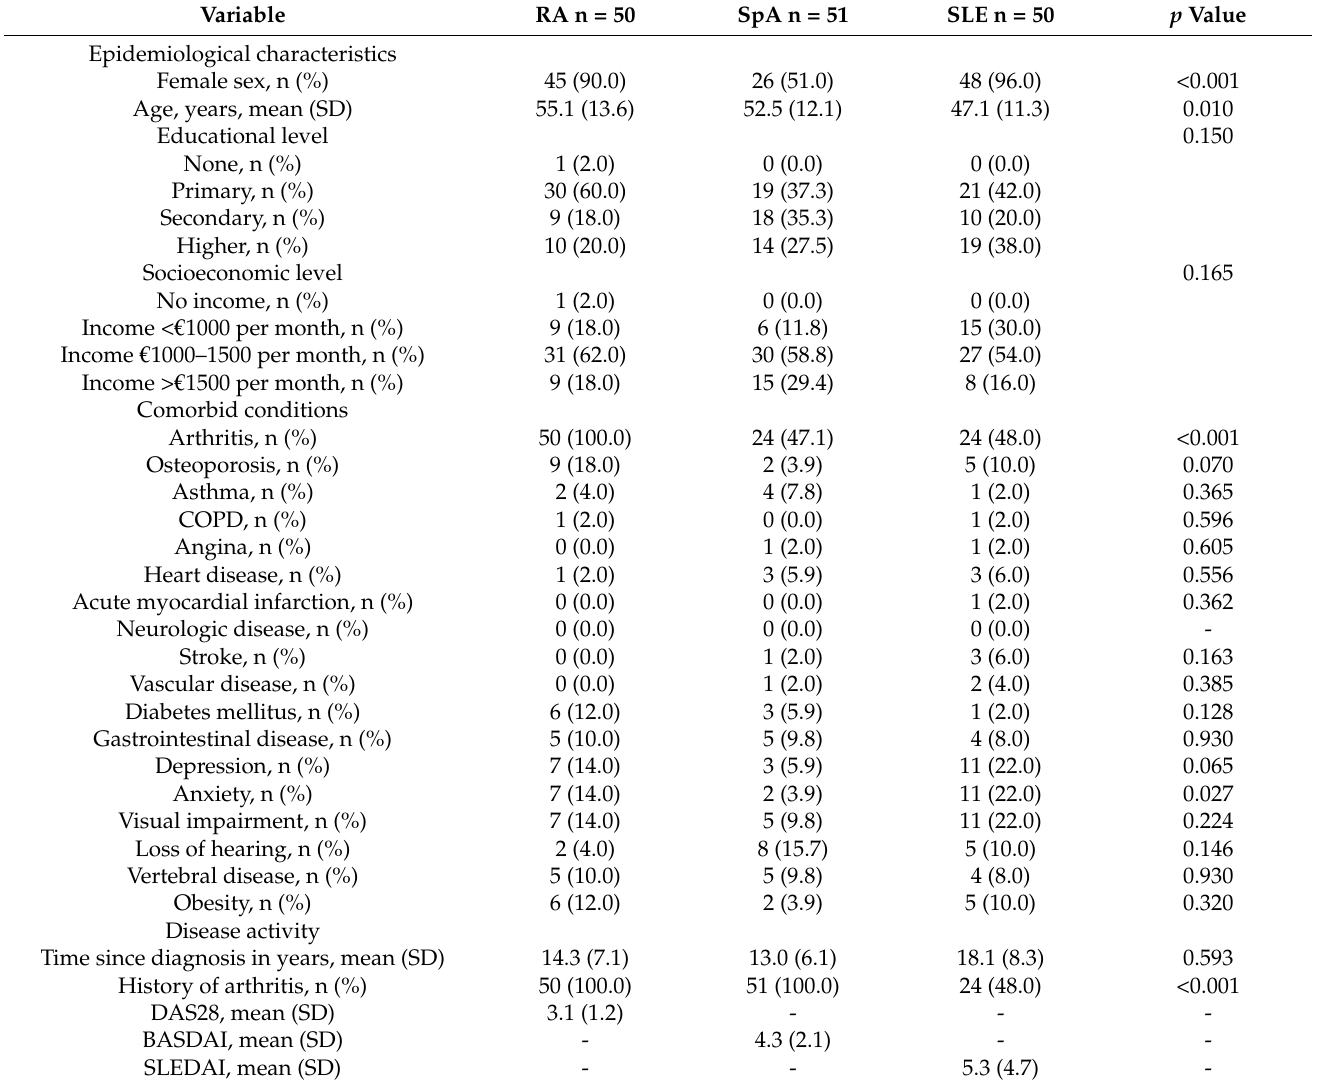
Table 1. Baseline clinical characteristics of 151 patients with rheumatic